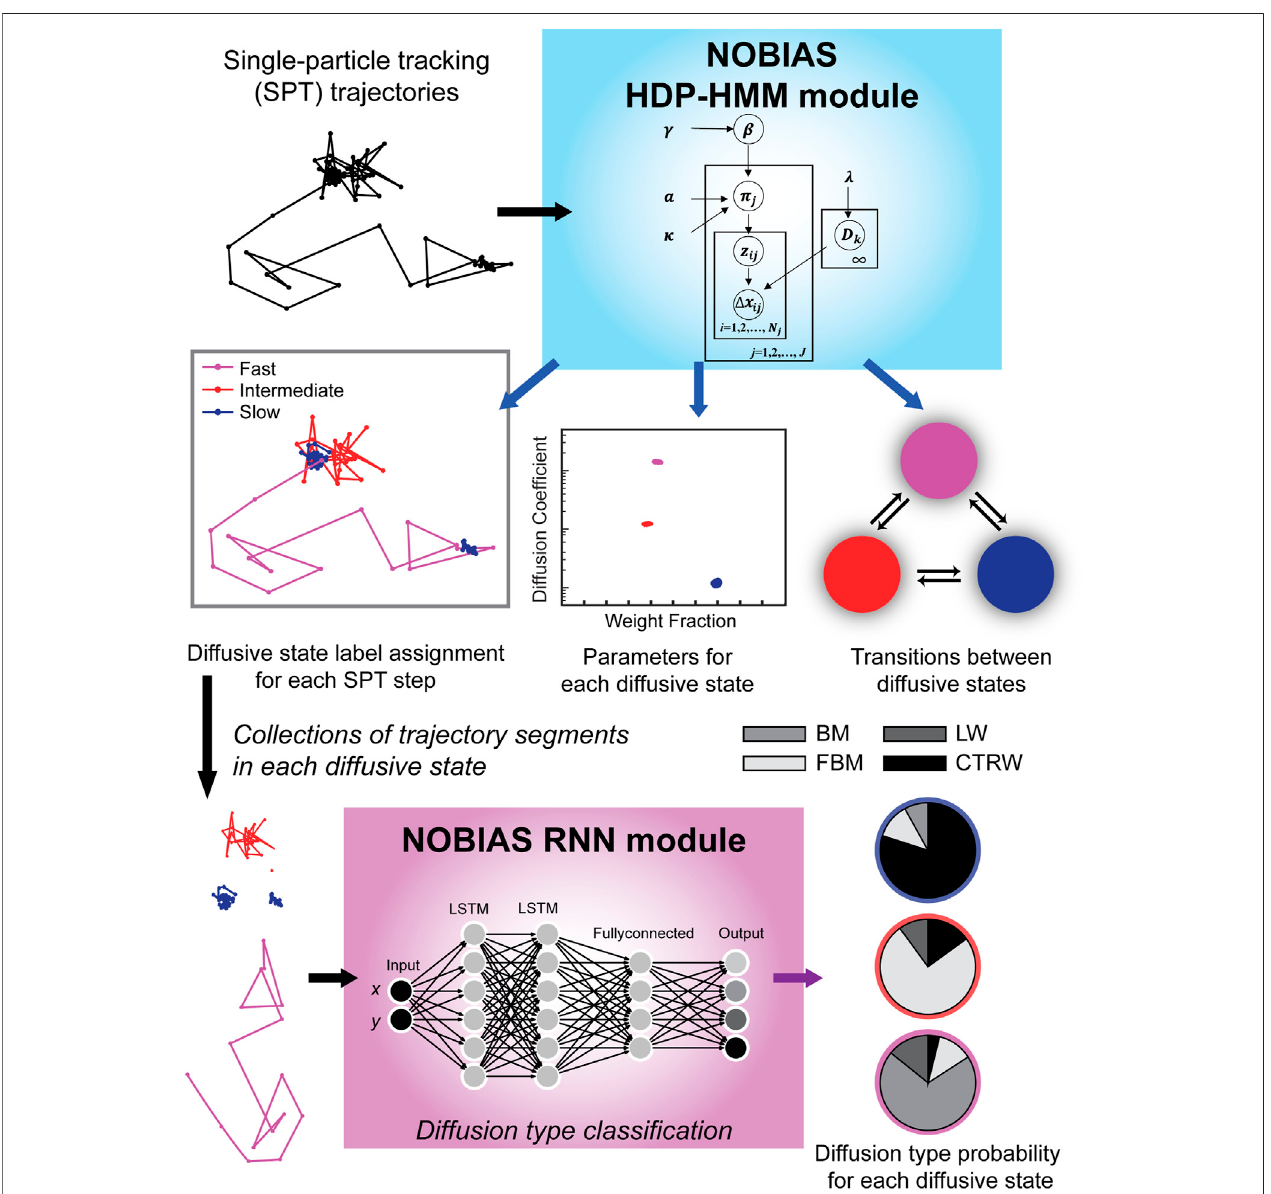
FIGURE 1 | NOBIAS work fl ow. (1) Single-particle tracking (SPT) trajectory datasets are processed in the NOBIAS HDP-HMM module: the observed data (the displacements, Δ x ) are analyzed in the context of the emission parameters (the diffusion coef fi cients, D ). The state sequence, z , indicates the diffusive state corresponding to each step, and the transition matrix, π , is estimated with a Hierarchical Dirichlet process prior using concentration hyperparameters a and c and the stickyparameter, κ .TheHDP-HMMmoduleprovides D andtheweightfraction foreachdiffusivestate,the π fortransitionprobabilitiesbetweenthesestates,anda statelabelassignmentforeachSPTstep.(2)IntheNOBIASRNNmodule,trajectorysegmentsofthesamediffusivestatearecollectedandputinapre-trainedRecurrent Neural Network (RNN) with two long short-term memory (LSTM) layers to classify the diffusion type for each diffusive